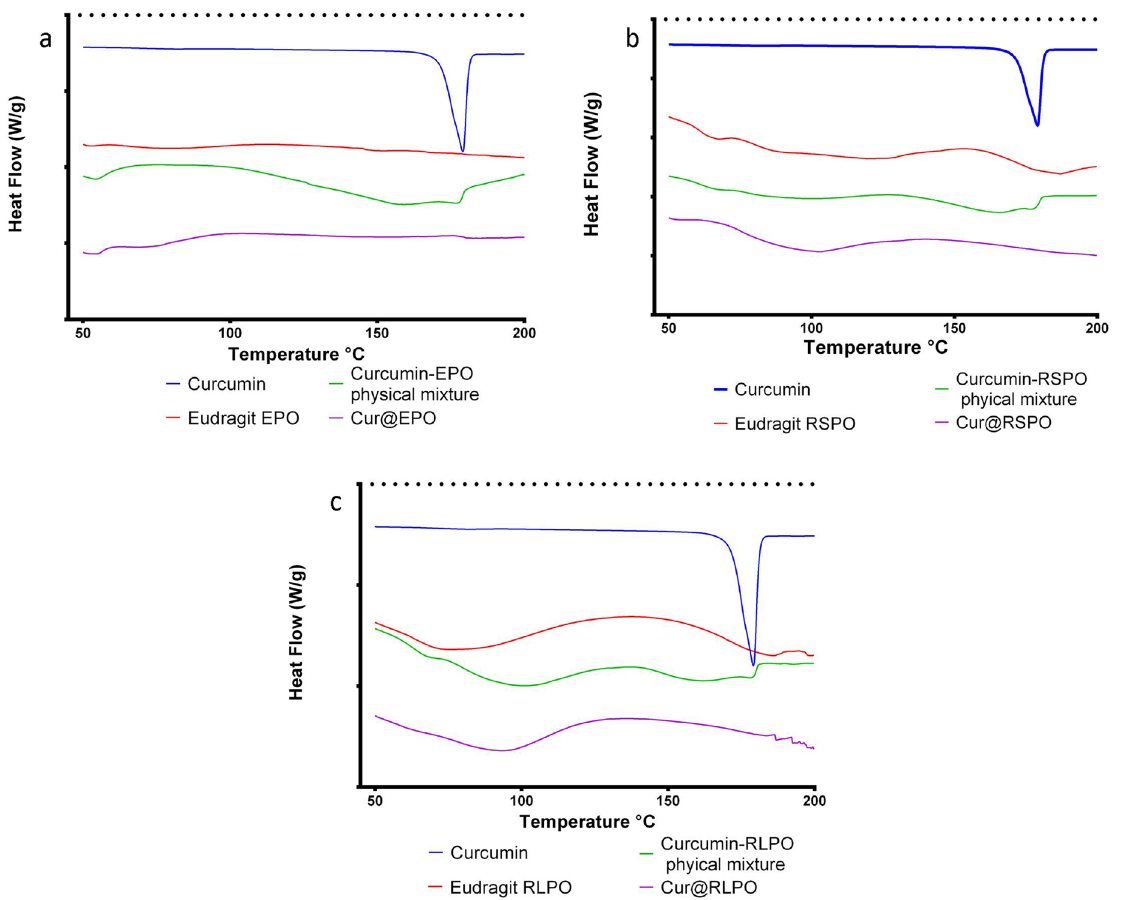
FIGURE 2 - Differential scanning calorimetry (DSC) thermograms of a: curcumin, Eudragit E PO, physical mixture and curcumin Eudragit E PO solid dispersion; b: curcumin, Eudragit RS PO, physical mixture and curcumin Eudragit RS PO solid dispersion; c: curcumin, Eudragit RL PO, physical mixture and curcumin Eudragit RL PO solid